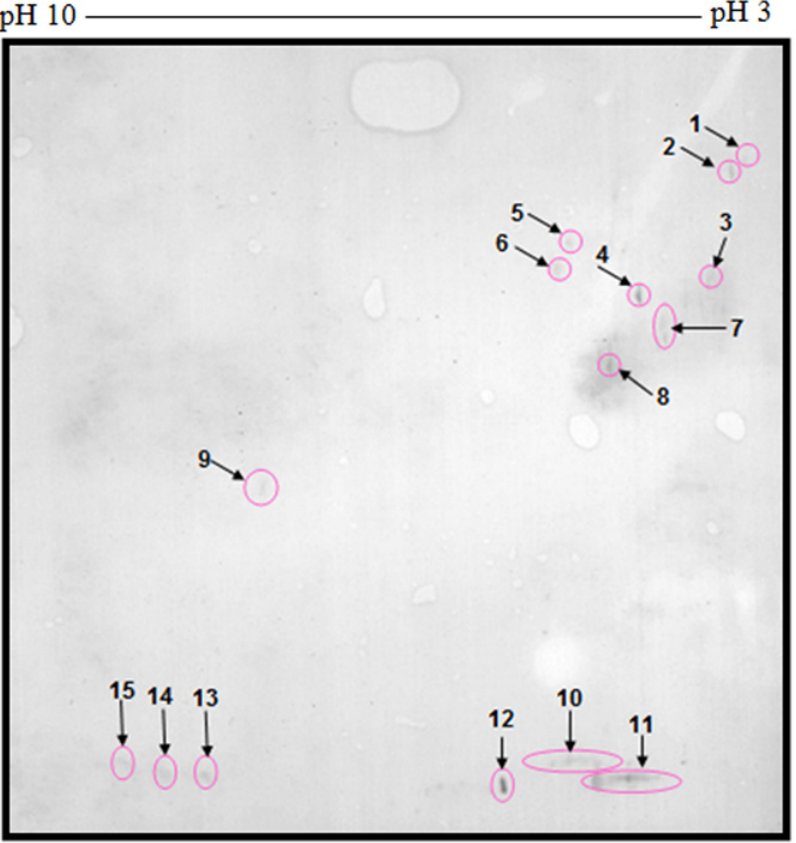
Fig 3. 2D-immunoblotting of T . gondii strain RH tachyzoite proteins probed with pooled control sera revealed the appearance of immunoreactive polypeptide spots.